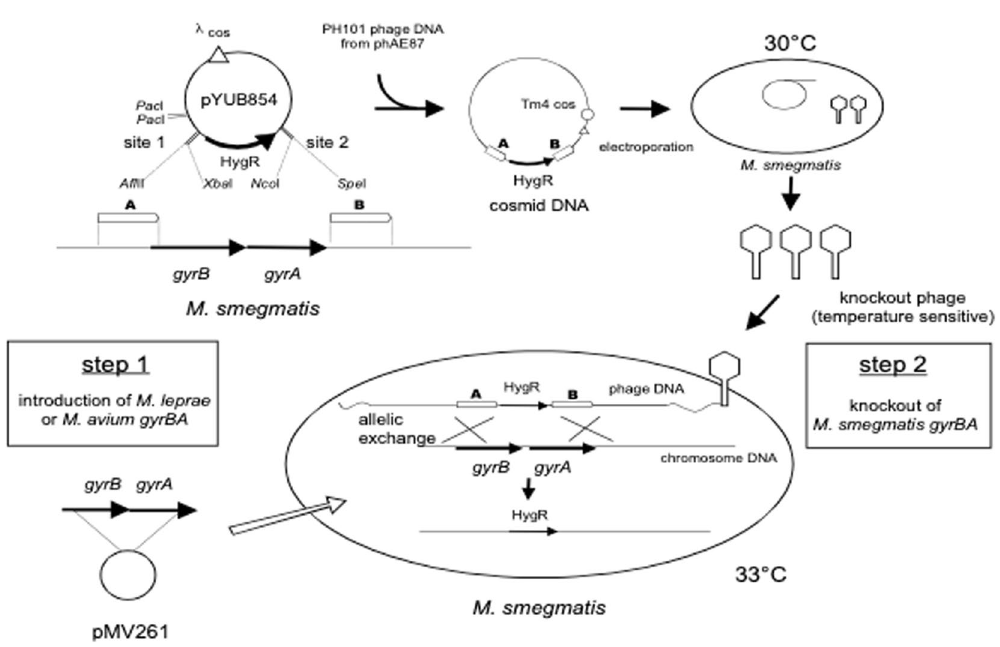
Figure 5. Scheme for construction of replacements Mle , Mavi gyrB - gyrA genes into Msmeg complete